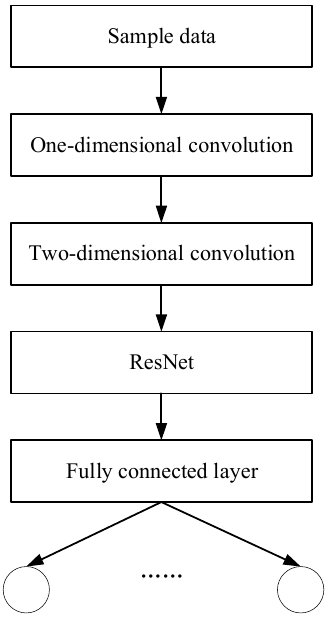
Figure 1. Spatial model framework.